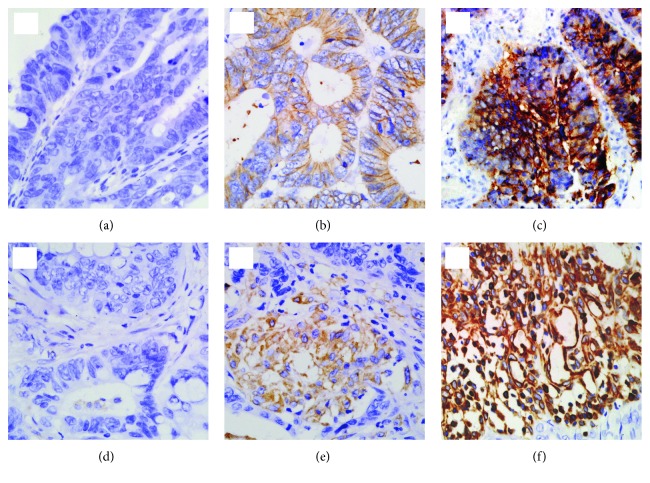
Representative pictures by immunohistochemistry for E-cadherin and vimentin expression in specimen. (Magnification ×400) E-cadherin expression: (a) negative expression, (b) low expression, and (c) high expression. Vimentin expression: (d) negative expression, (e) low expression, and (f) high expression.